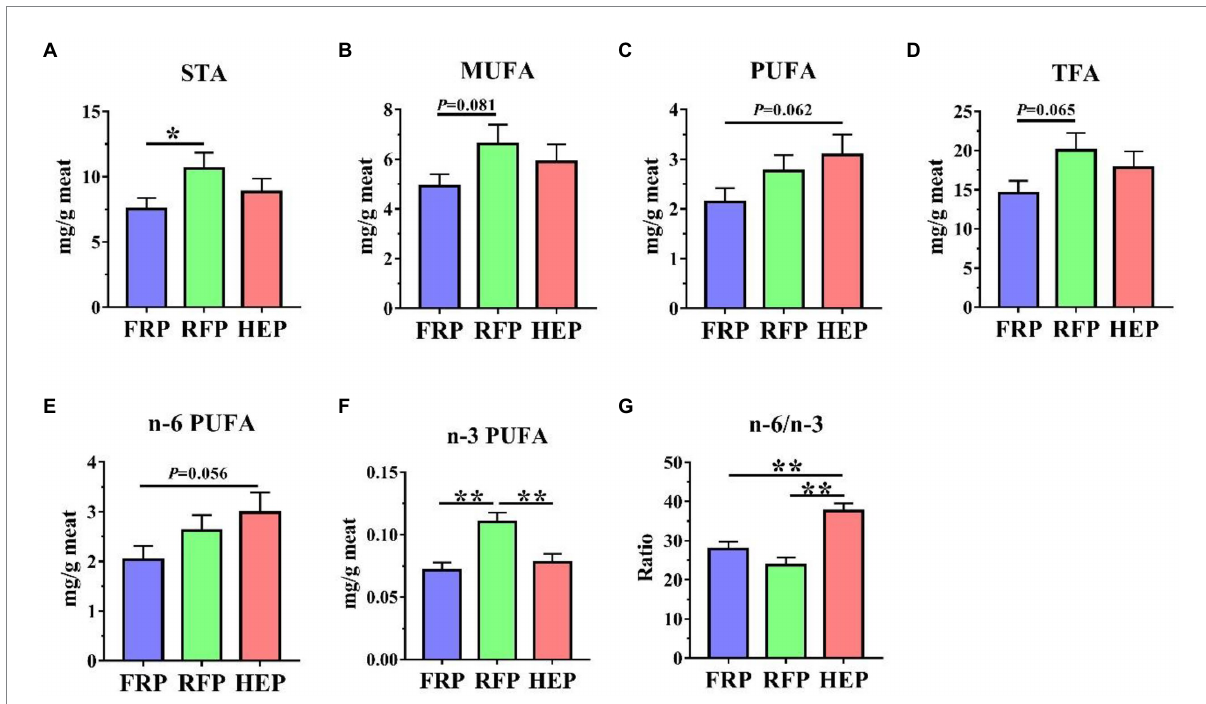
FIGURE 2 Effects of different feeding patterns on concentrations of fatty acids in semitendinosus muscle (SM) of Tibetan pigs. The concentrations of saturated fatty acid (STA, A ), monounsaturated fatty acid (MUFA, B ), polyunsaturated fatty acid (PUFA, C ), total fatty acid (TFA, D ), n-6 PUFA (E) , n-3 PUFA (F) and n-6/n-3 PUFA ratio (G) in SM of Tibetan pigs, respectively. Data are expressed as mean ± SE ( n = 6–7). * and ** indicates p <0.05 and p <0.01, respectively. FRP: free-ranging Tibetan pigs; RFP: feeding the regular Tibetan pig diets; HEP: feeding the high energy content